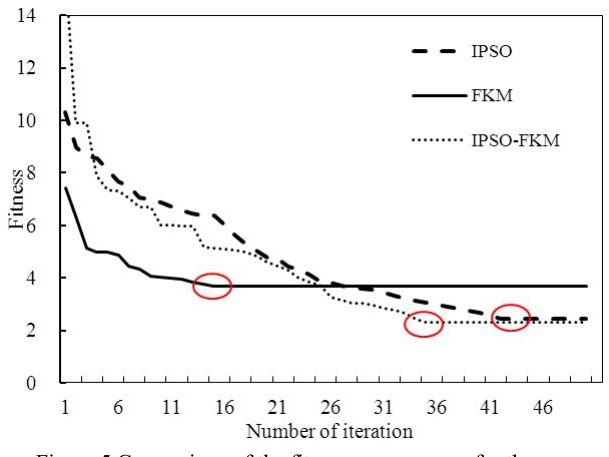
Figure.5 Comparison of the fitness convergence for three